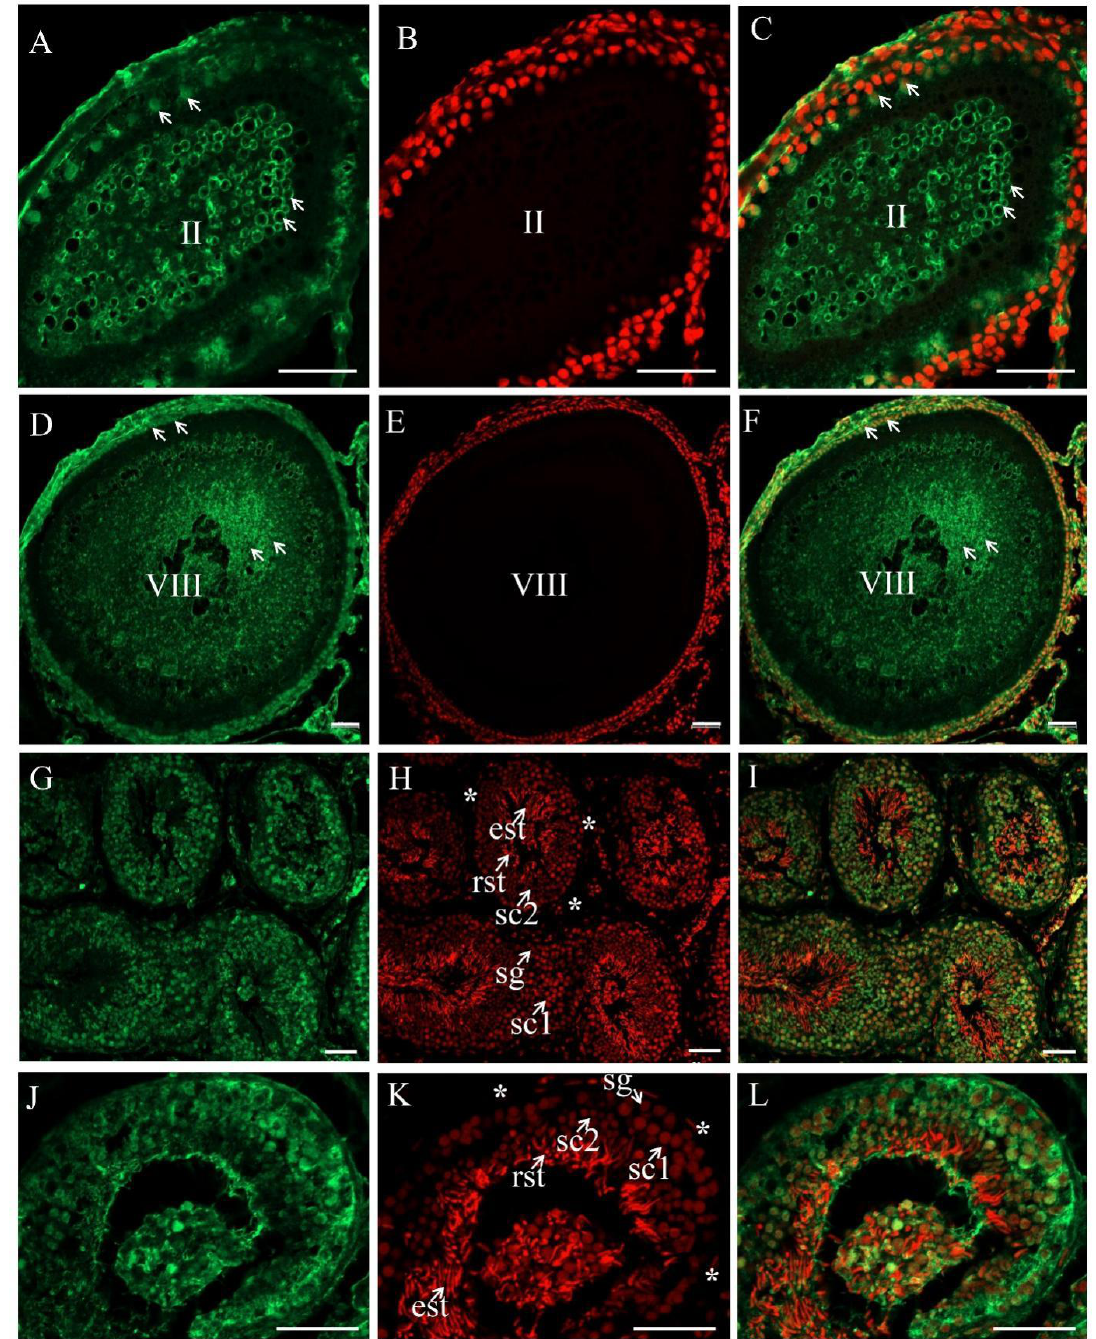
Figure 6. PsNanog protein expression in germ cells. The cellular distributions analysis of PsNanog protein during oogenesis and spermatogenesis. ( A ) Immunostaining was performed on the ovary and testis sections with the antibody aPsNanog (green in A , D , G , J ), nuclei were counterstained with propidium iodide (PI; red in B , E , H , K ). ( C ) Merged images of A and B, ( F ) merged images of D and E, ( I ) merged images of G and H, ( L ) merged images of J and K. ( A – C ) Stage II oocytes, ( D – F ) stage VIII oocytes. PsNanog signals were detected in the cytoplasm and granulosa of Stage II oocytes, while PsNanog was localized in the cytoplasm of the cortical region and granulosa of Stage VIII oocytes (the arrow indicated). PsNanog signals were detected in spermatogonia (sg), primary spermatocytes (sc1) and secondary spermatocytes (sc2), round spermatids (rst), and elongated spermatids (est). Somatic cells were labeled with stars. Scale bars, 50 µ